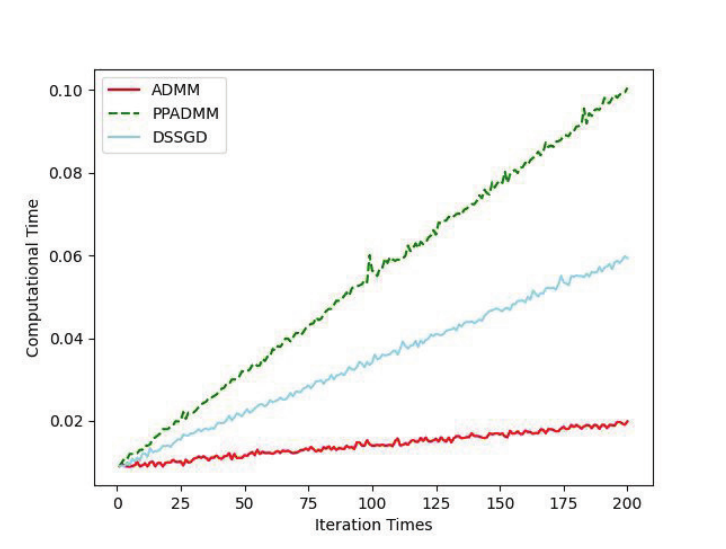
Figure 5. Comparison of the computation time of ADMM, PPADMM, and